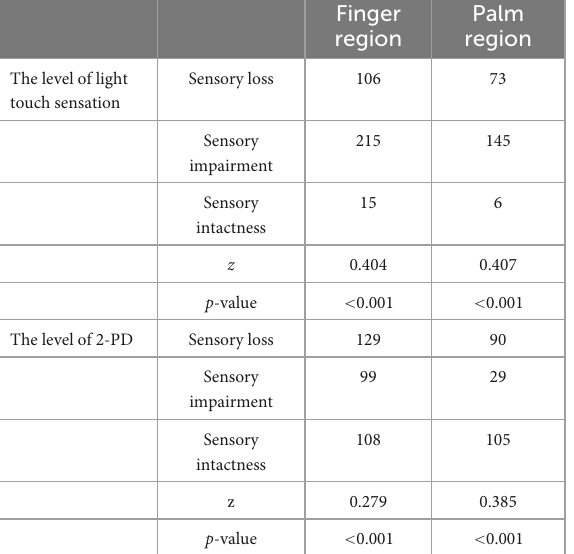
Finger Palm region